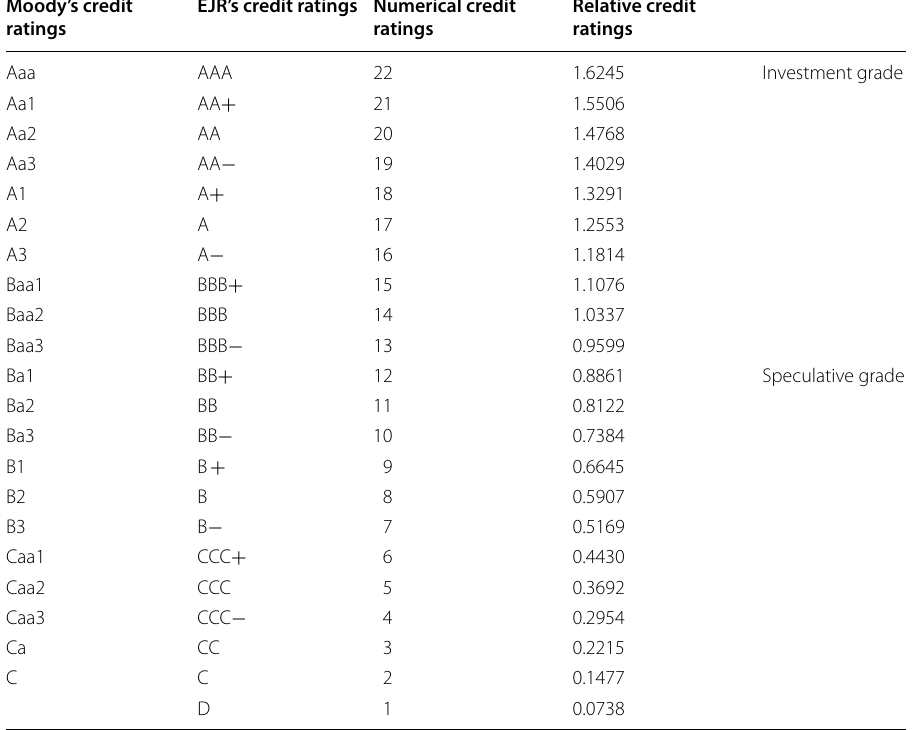
Table 7 Conversion scale from numerical to relative credit ratings by Moody’s and EJR Moody’s credit